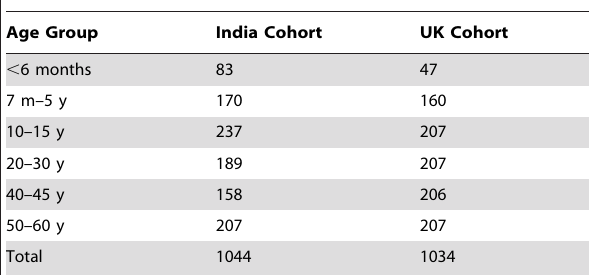
Table 1. Summary of sera tested.